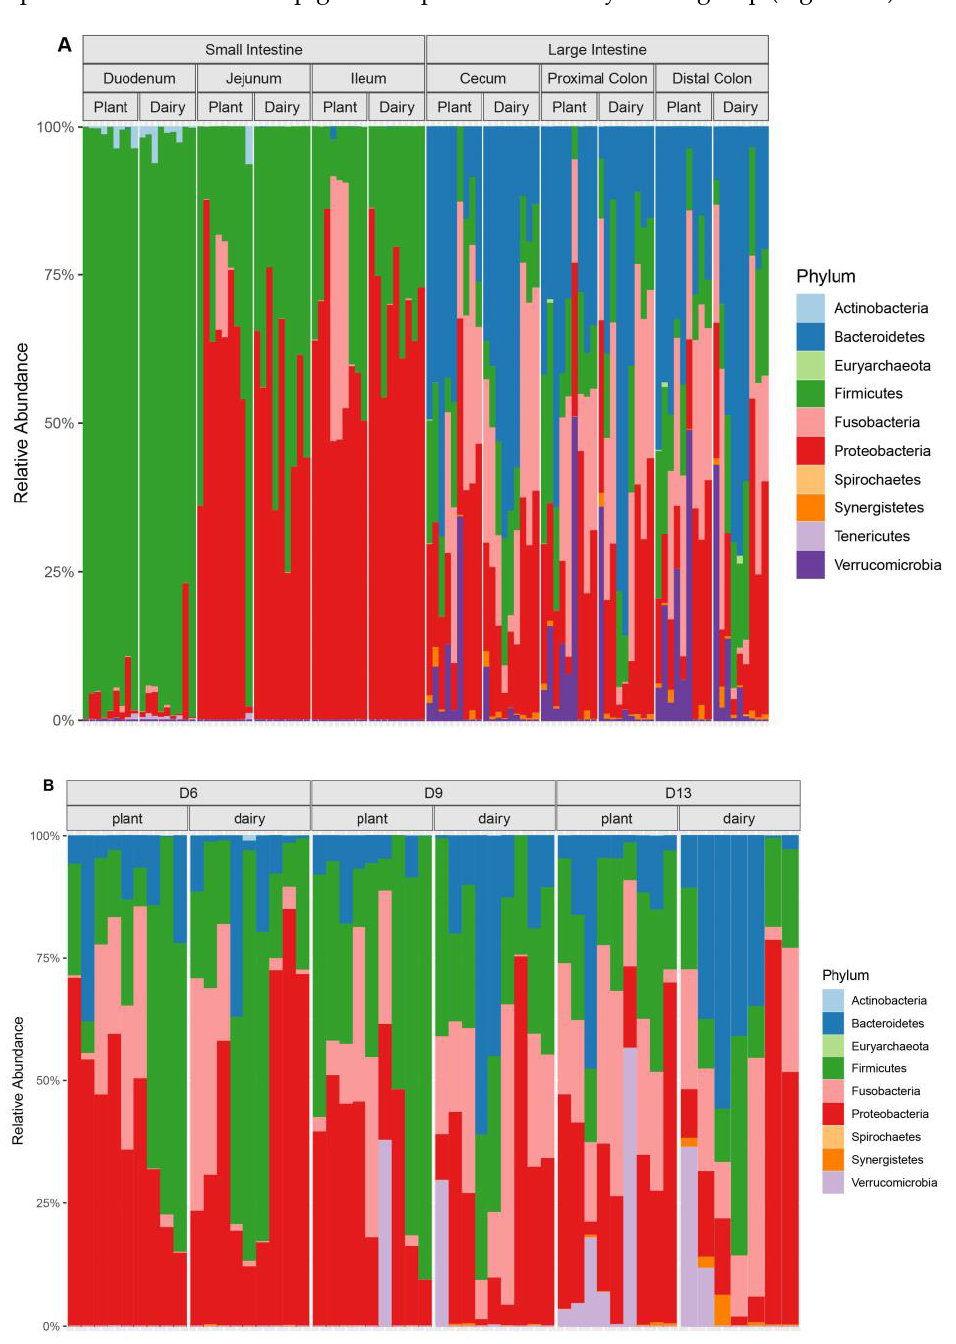
Figure 1. Distribution of the bacterial phyla within the small and large intestinal regions and feces of piglets fed either a plant- or a dairy-based formula diet. ( A ) Bacterial phyla within the small and large intestinal contents of day 21 old piglets. ( B ) Fecal microbiota composition on different days at the phyla level. Data generated by 16S rRNA amplicon sequencing targeting the V3–V4 variable region. Sequencing counts (OTUs) were summed to the phylum level and then proportionally nor- malized.